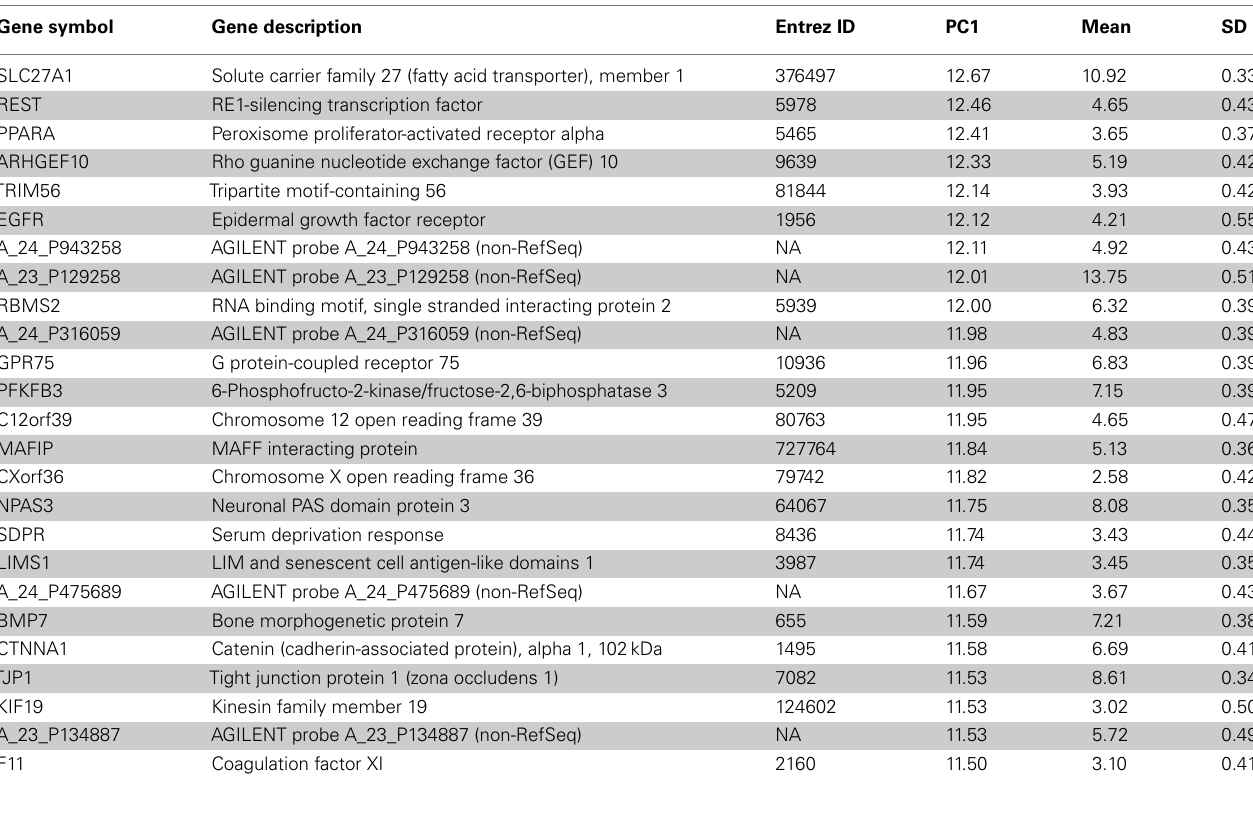
Table 1 |Top 25 genes in the oligodendrocyte-enriched gene set of human H0351.2001 sorted by PC1